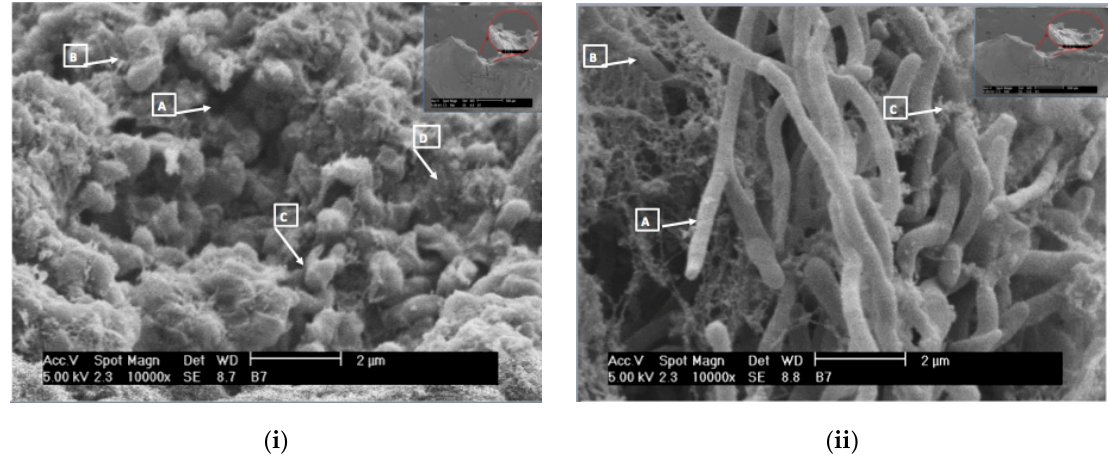
Figure 1. Scanning electron microscopic images of the apical of the apical foramen of a tooth showing a mature biofilm of ( i ) Leuconostoc spp. (10,000×). A multilayered polymeric matrix is evident. Also noticed are communicating channels in the biofilm (A), extracellular fibers secreted by bacterial cells (B), metabolically active cells characterized by cell division (C) and compact extracellular polymers (D); ( ii ) Biofidobacterium spp. in a maturation state (10,000×). Secretion of polymers in granular form by the bacterial cells (A), microfilaments of extracellular polymers surrounding the rod shape of the microorganism (B) and extracellular polymers in the maturation state (C) can be seen (Courtesy: Dr. Ana Maria González Amaro, Maria Verónica Méndez González, UASLP Mexico).